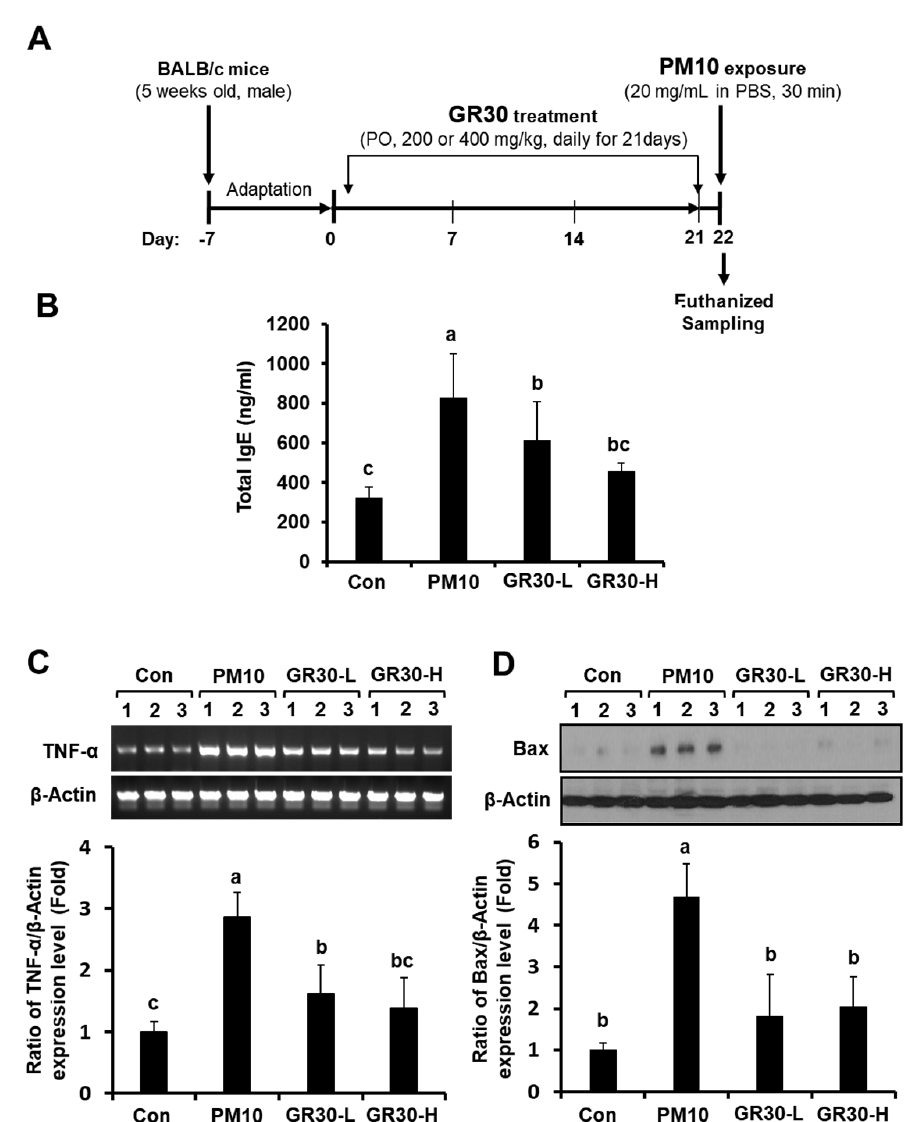
Figure 6. GR30 suppresses PM10-induced serum IgE production and TNF- α and Bax expression in lung tissues. ( A ) Protocol for animal treatment. Mice were orally administered PBS only (control group, PM10 group), 200 mg/kg/day or 400 mg/kg/day GR30 every day for 21 consecutive days. The mice were exposed to PM10 (20 mg/mL, w / v , in PBS) for 30 min by inhalation using a compressor nebulizer. Effects of GR30 on the levels of ( B ) serum IgE, ( C ) TNF- α mRNA expression and ( D ) Bax protein expression in PM10-challenged mice. The values are expressed as the means ± SD ( n = 8), and the means with different letters are significantly different from each other ( p < 0.05), as determined by one-way ANOVA followed by Dunnett’s multiple comparison test. Con, untreated normal control group; PM10, PM10-inhaled control group; GR30-L, GR30 (200 mg/kg)-treated group; GR30-H, GR30 (400 mg/kg)-treated